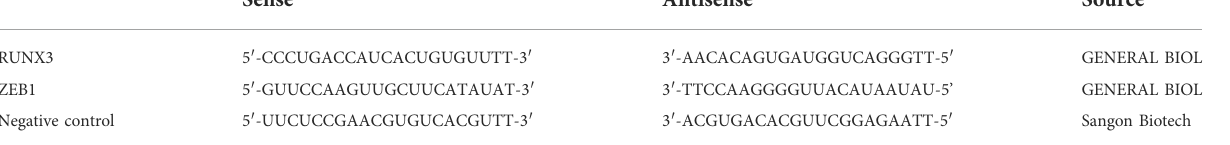
TABLE 1 Base pairs of siRNAs for